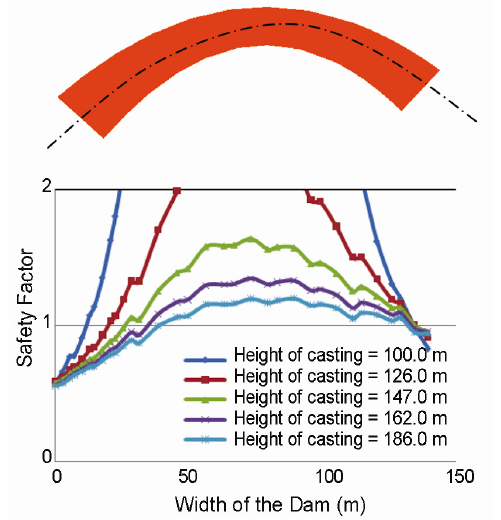
Fig. 10. Safety factors path along the dam width (EL.105.0